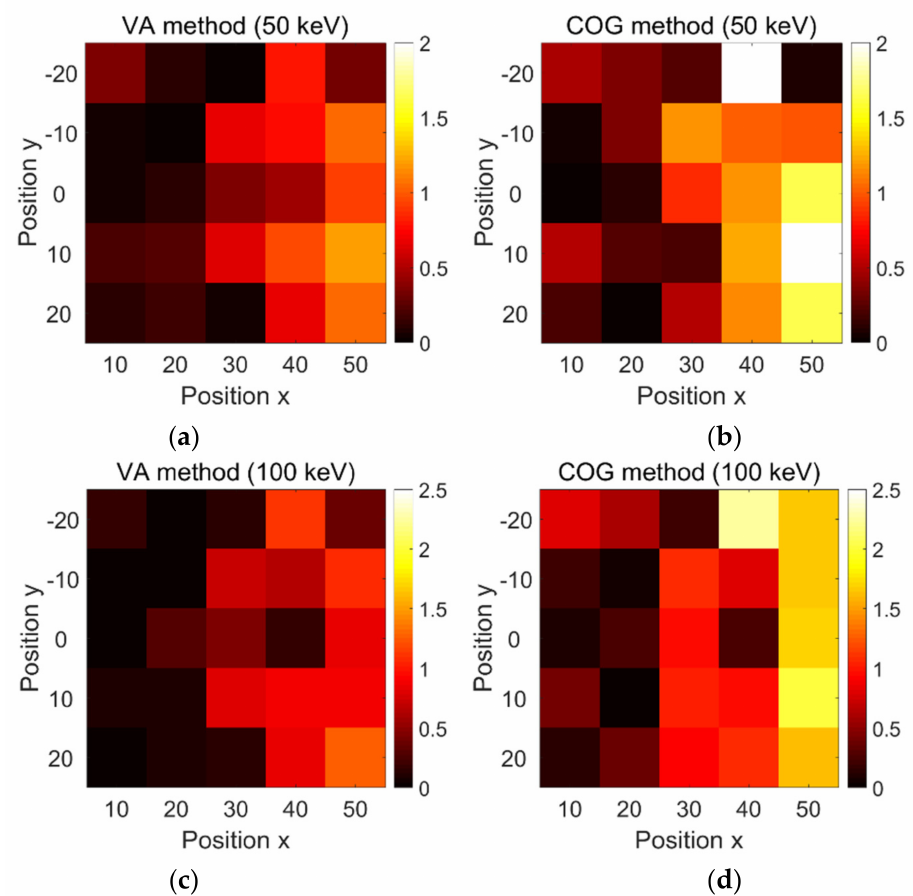
Figure 9. Decoding accuracies of the VA method at ( a ) 50 keV energy window and ( c ) 100 keV energy window, as well as COG method at ( b ) 50 keV energy window and ( d ) 100 keV energy